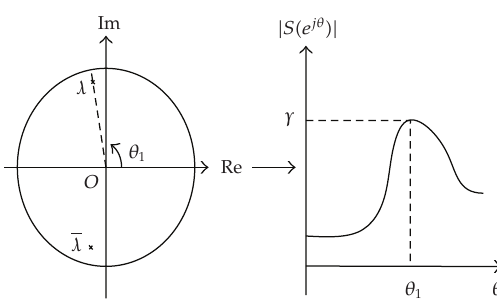
Figure 2: Influences of a spectral zero λ on | S (cid:2) z (cid:3) | .